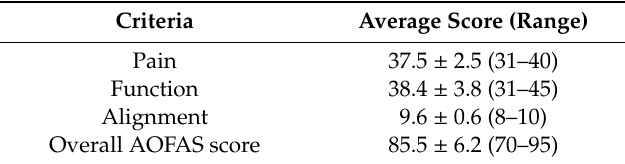
Table 6. Results according to